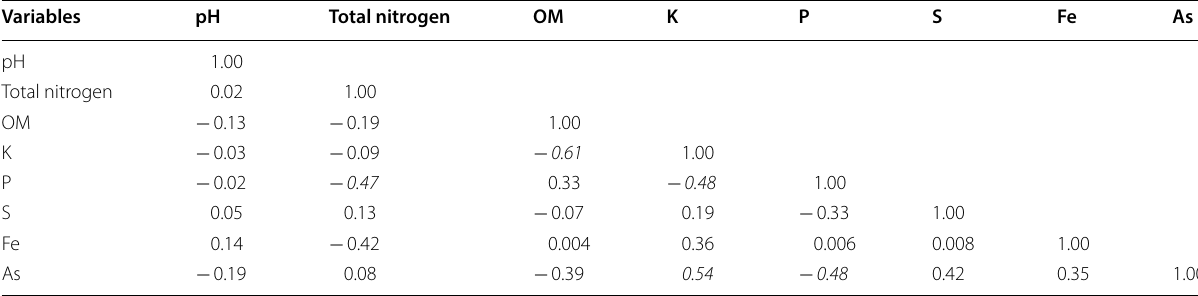
Table 4 The correlation matrix for sub-surface soil samples Variables